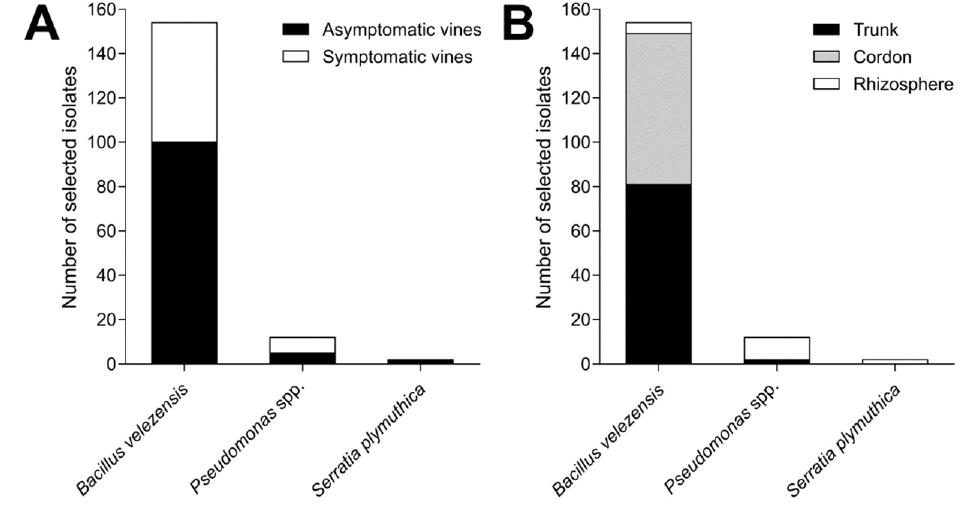
Figure 5. Distribution of selected bacterial isolates ( n = 172) that showed inhibition levels over 40% against the mycelial growth of Neofusicoccum parvum and Diplodia seriata according to the vine health status ( A ) and the tissue they were recovered from ( B ).